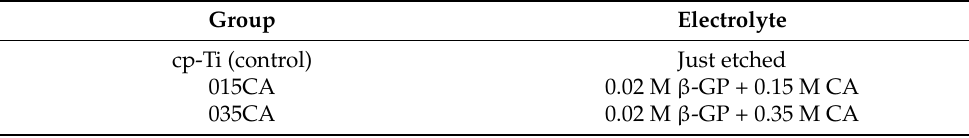
Table 1. Groups and respective electrolyte composition.